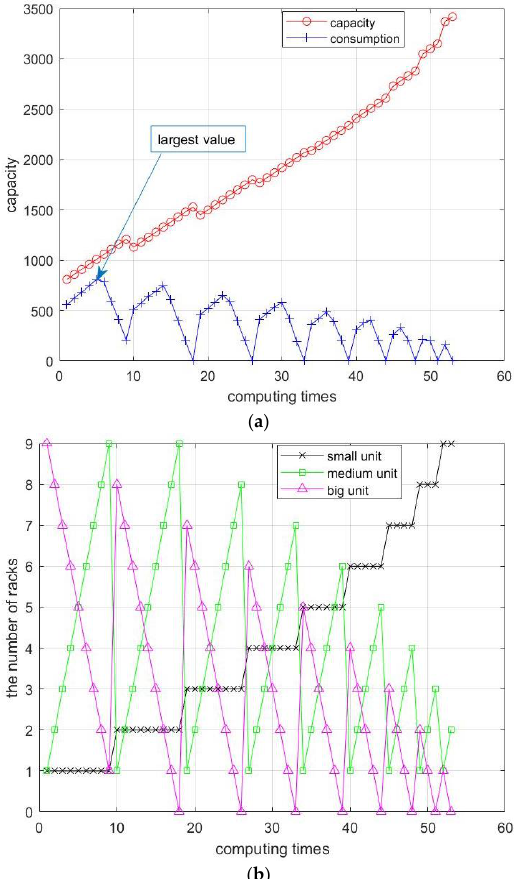
Figure 10. The capacity and consumption of Type B: ( a ) the capacity and consumption; and ( b ) the number of small, medium and big units.